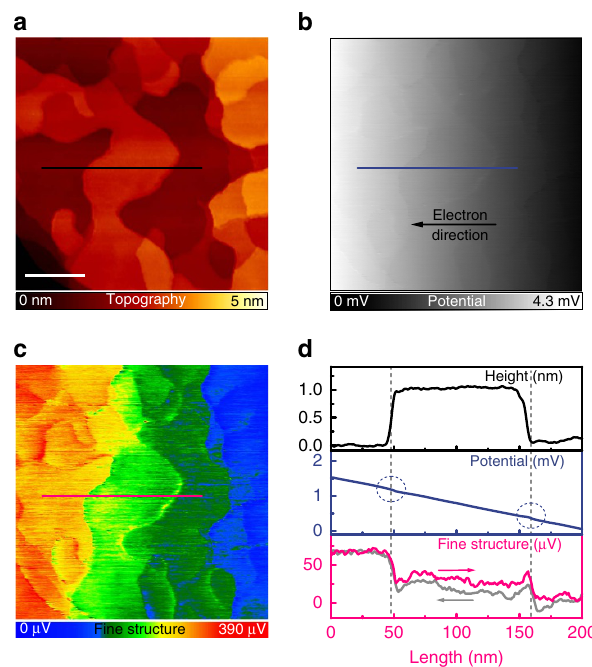
Figure 2 | Results of the STP measurement. ( V mod ¼ 20mVpp at 2.1kHz, I t ¼ 12pA, V trans ¼ (cid:2) 1.3V, I trans ¼ (cid:2) 1.9mA, 315 (cid:4) 315nm 2 ). White scale bar, 75nm. ( a ) Topography of the Bi 2 Se 3 film. ( b ) The image of the potential for the corresponding surface area as in a mainly exhibits a constant gradient corresponding to the electric field induced by the contacting tips. ( c ) Corresponding ‘fine structure’ of the potential (gradient subtracted). The colour coding helps to identify rather sharp drops of the potential at surface step edges. ( d ) Averaged line profiles (about 7 scan lines) across a